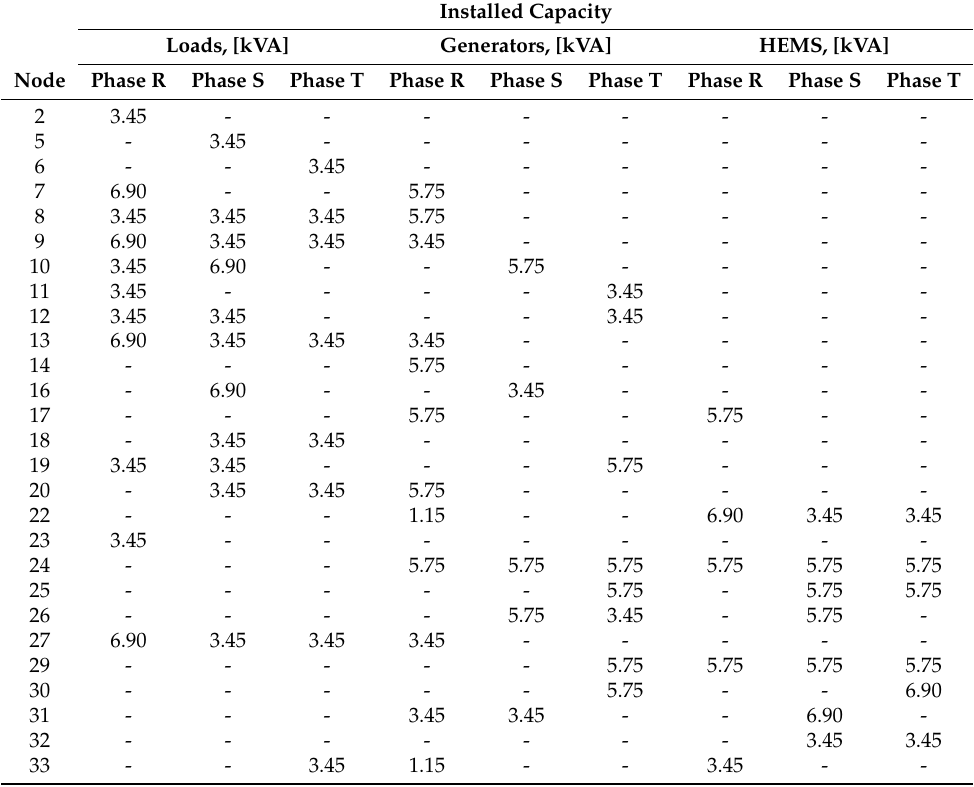
Table A4. Installed capacity of loads, generators, and